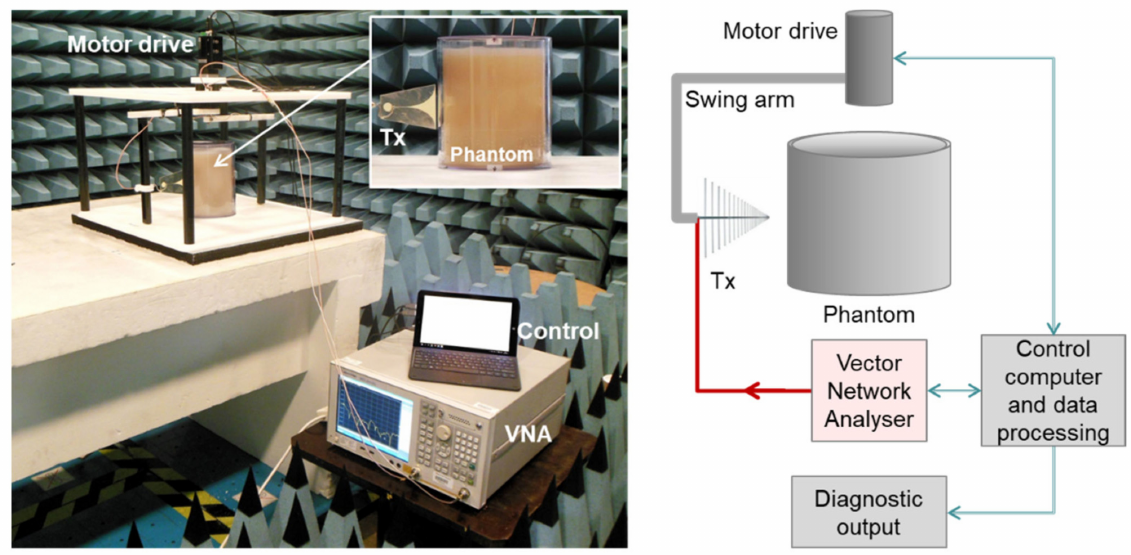
Figure 2. Components of the experimental scanning